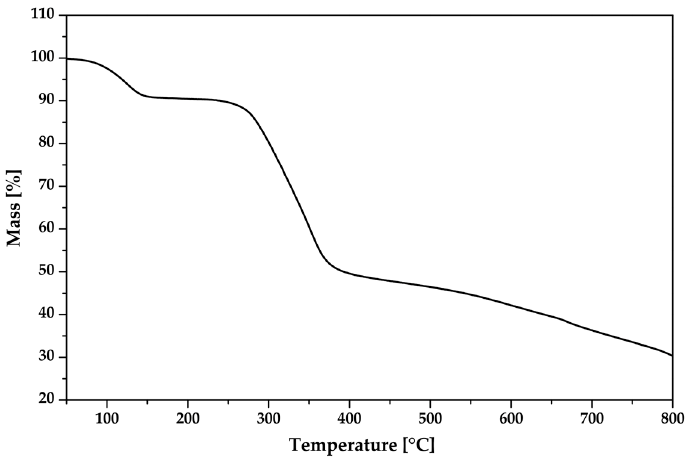
Figure 13. The thermogravimetric analysis of the crystalline [Zn(C 12 H 8 N 2 ) 3 ]C 15 H 13 N 3 O 9 ·5H 2